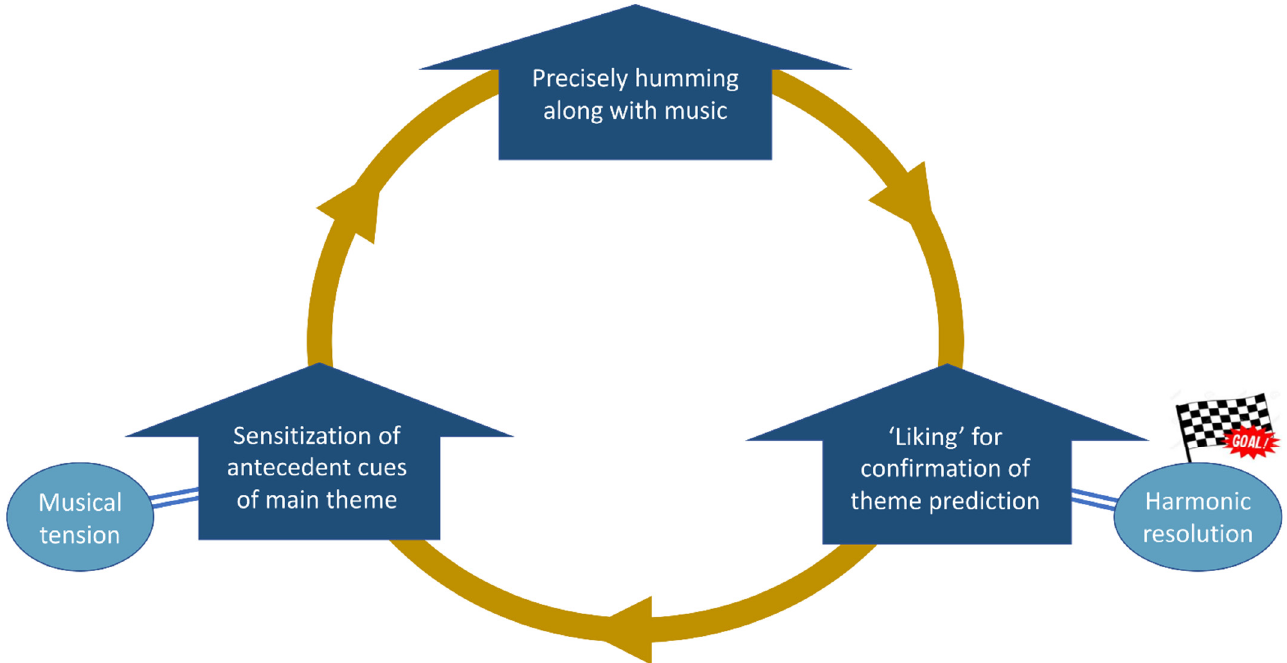
Figure 5. Putative model for the enjoyment and learning of music (inspired by the incentive-sensitization theory of addiction). During exposure to a musical piece, the antecedent cues of the main theme may increase attention to covert humming along with the music. More precise humming may lead to more intense ‘liking’ for the confirmation of theme prediction. Repeated intermittent experiences of ‘liking’ may in turn cause sensitization to the antecedent cues of the main theme. The listener’s ‘wanting’ and ‘liking’ may be facilitated by the musical tension of the antecedent cues and the harmonic resolution at the main theme’s entry, respectively.